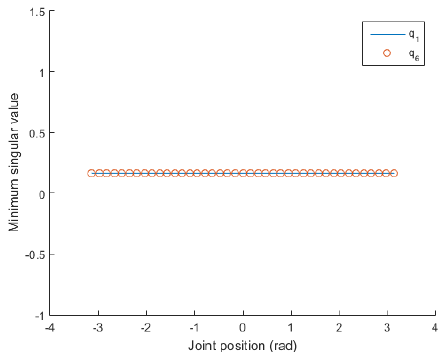
Figure 2. The distributions of the minimum singular values with the changes in q 1 and q 6 . On the basis of the set of joint positions in step 1, a joint position is selected and set to 0 , π ± rad. From the remaining joints, a joint is selected and varied within its range, and the other joint positions remain unchanged. The distributions of the minimum singu- lar values with the changes in 2 q , 4 q , and 5 q can then be obtained, as shown in Figure 3. The distribution of the minimum singular value with the change in 3 d can also be ob- tained, as shown in Figure 4.